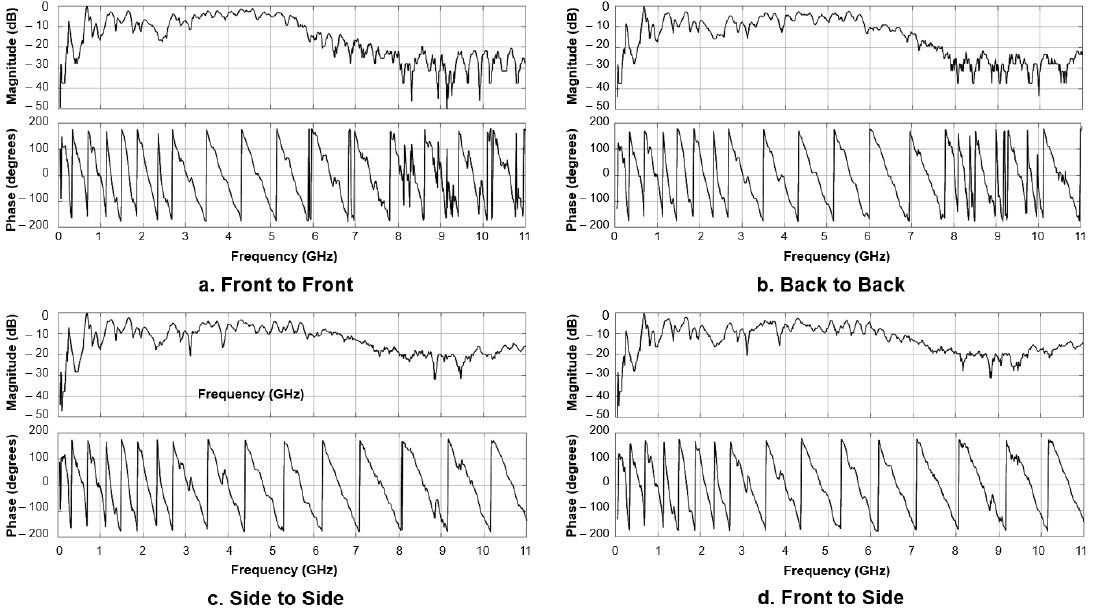
Figure 10. S 21 magnitude and phase of the LOS Wireless Link with different antenna positions: ( a ) Front-to-front, ( b ) back-to-back, ( c ) side-to-side and ( d ) front-to-side.